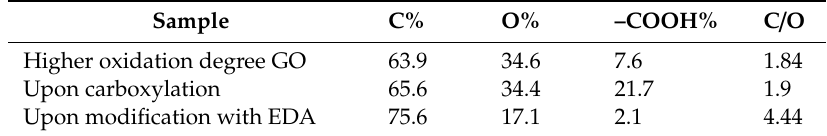
Table 2. Evolution of C% and O% atomic composition, –COOH contribution and C/O ratio for higher oxidation degree GO before and upon carboxylation and further EDA modification (XPS based).